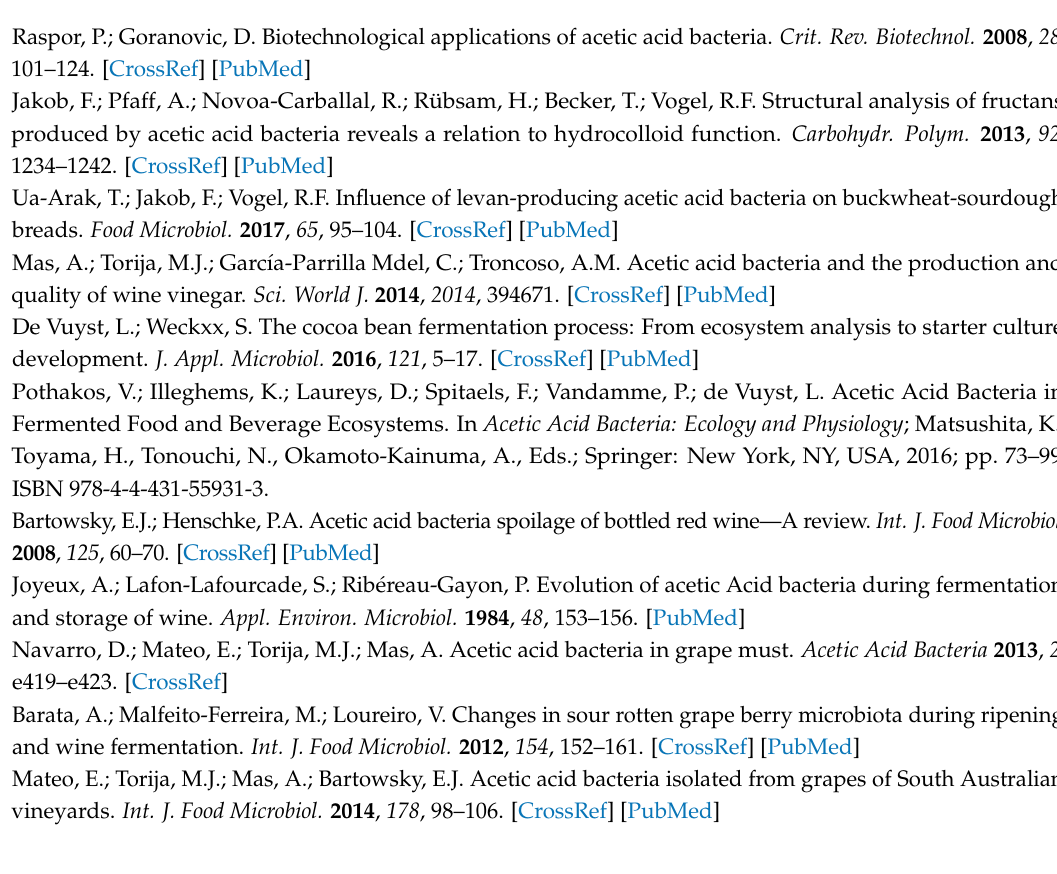
Table S1. Summary of the general features of G. cerinus phage